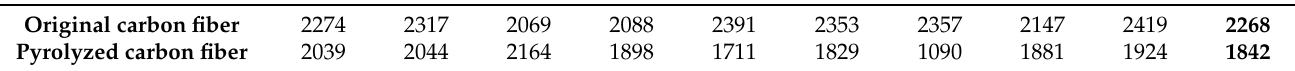
Table 5. Tensile strength of carbon fibers